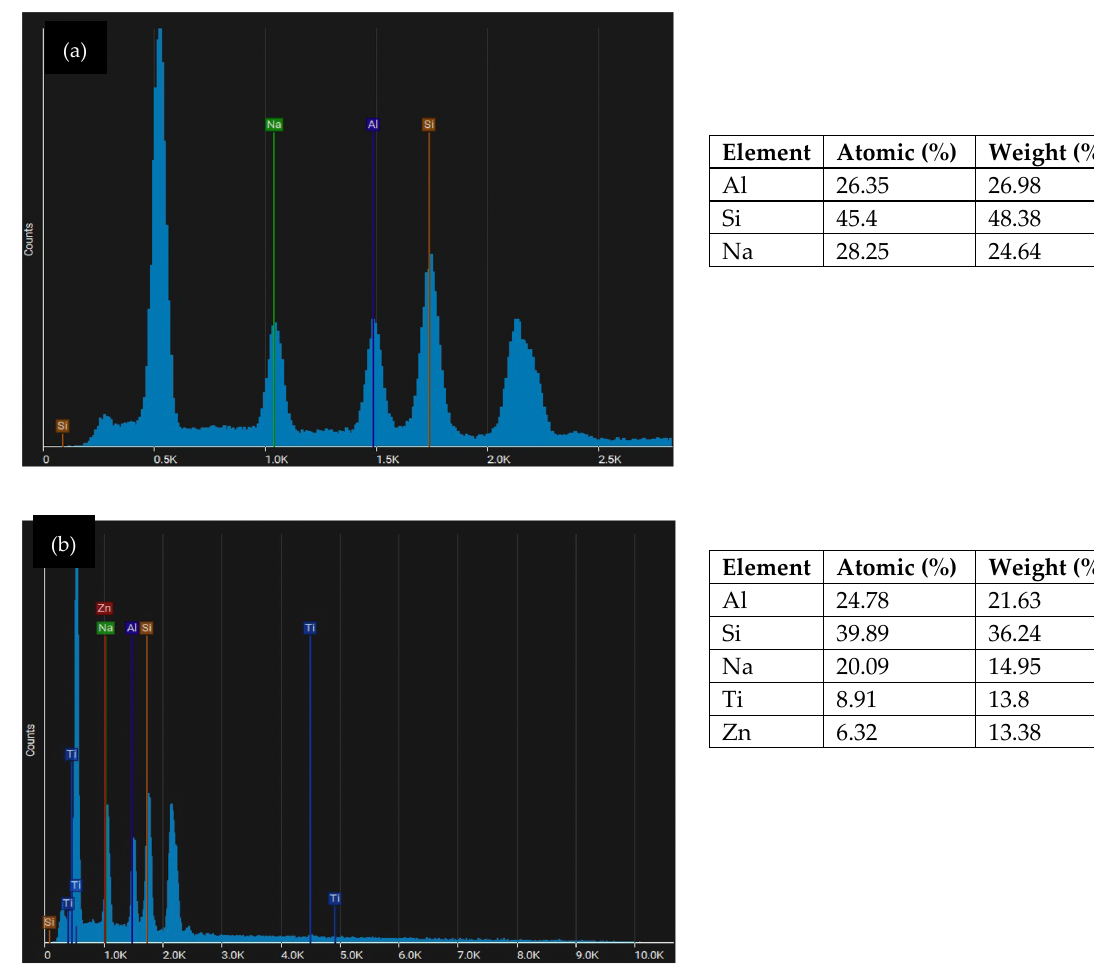
Figure 8. EDS analysis of metakaolin geopolymer coating: ( a ) GP; ( b ) GPTiO 2 Zn0.5.